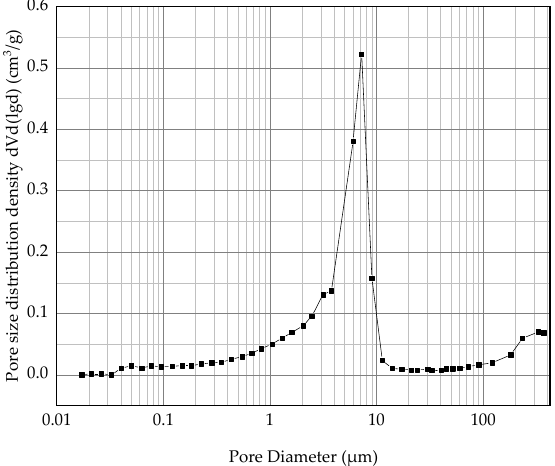
Figure 16. Pore size distribution density curve of soil sample 1.